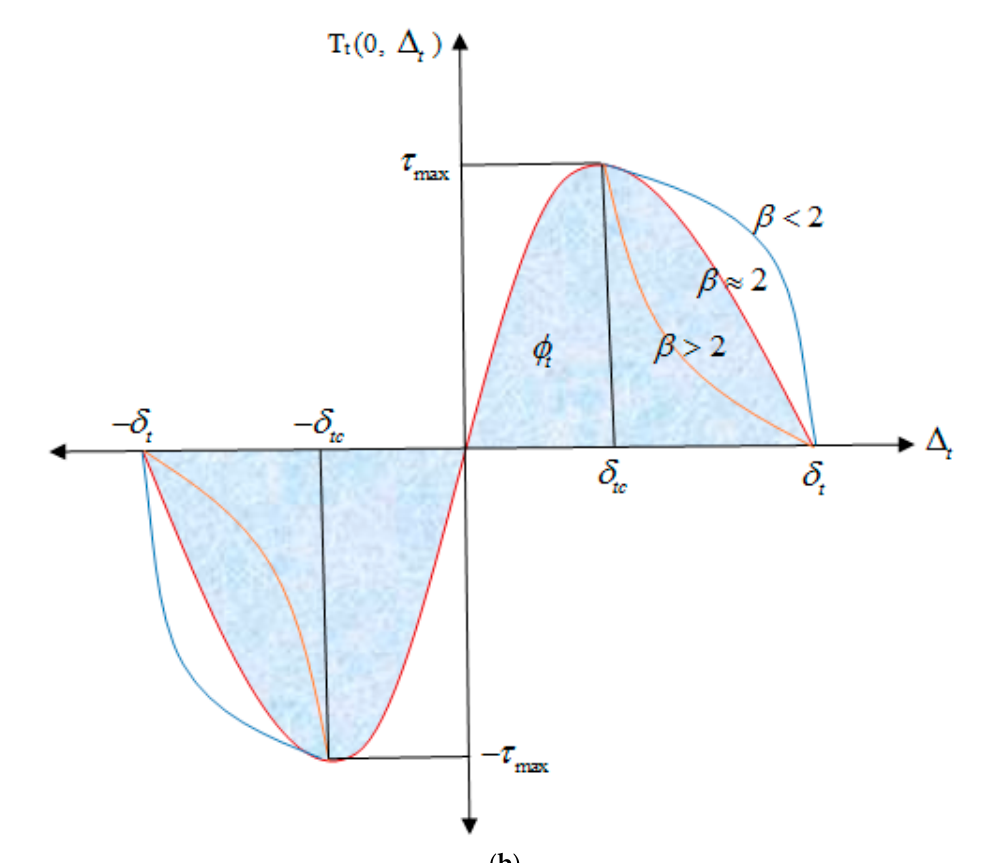
Figure 3. Traction–separation diagram in the ( a ) normal and ( b ) tangential mode [40,42].